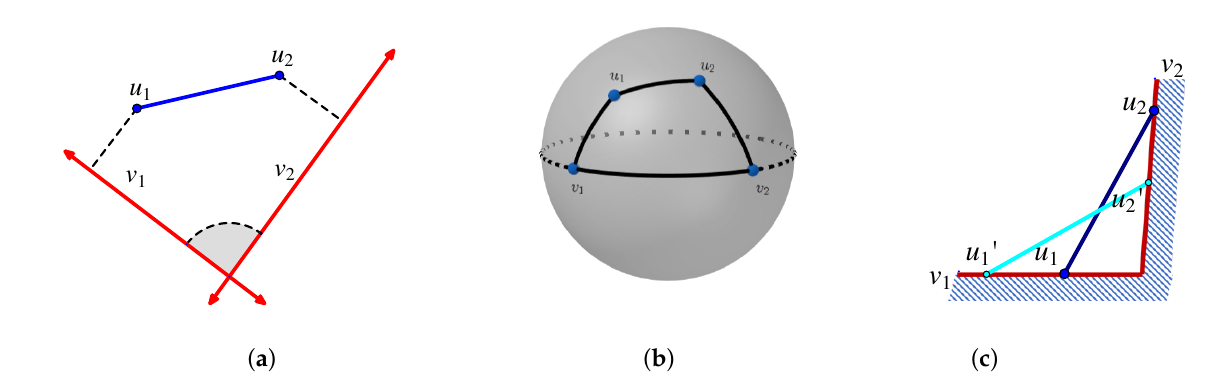
Figure 16. A point-line framework in R 2 ( a ) and the corresponding spherical bar–joint framework obtained by coning up ( b ). The points on the equator correspond to the lines of the point-line framework. Figure ( c ) has brought the sliders to the end points of the bar in ( a ) with a visible motion taking u 1 , u 2 to u (cid:48)